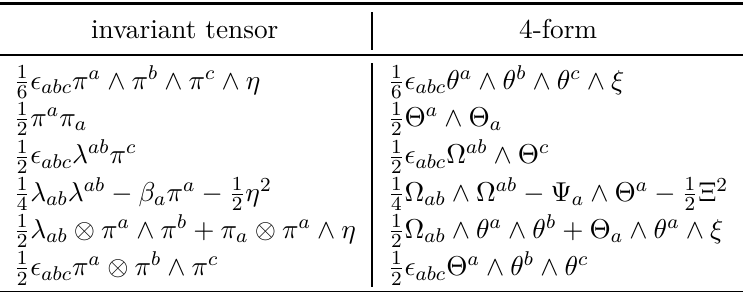
Table 9 . h -invariant tensors and the corresponding gauge-invariant 4